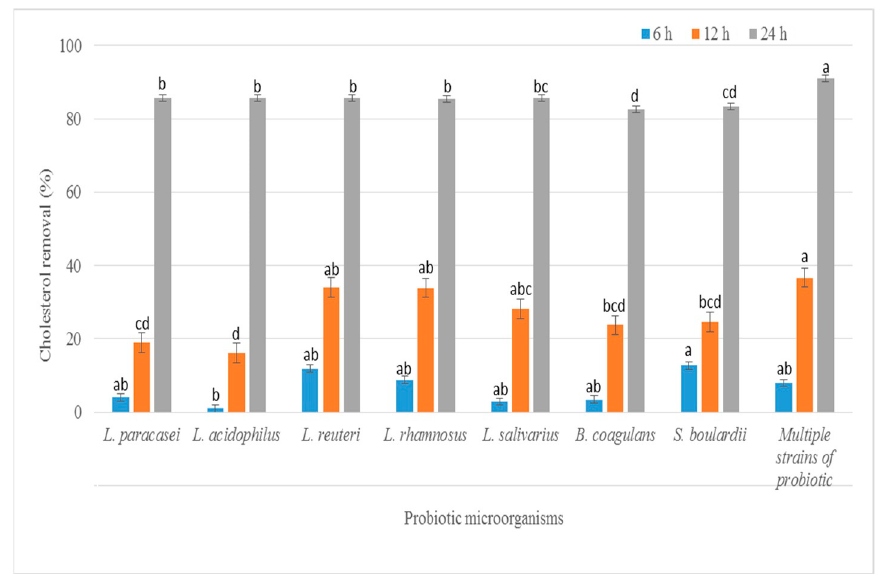
Figure 1. Cholesterol removal (%) of the seven probiotic strains and multi-strain probiotic incubated in media broth supplemented with 1.5 µg/mL water soluble cholesterol for 6, 12 and 24 h at 37 °C. Different lowercase between each time of incubation represents a significant difference using Duncan’s test with a confidence level of 95%.